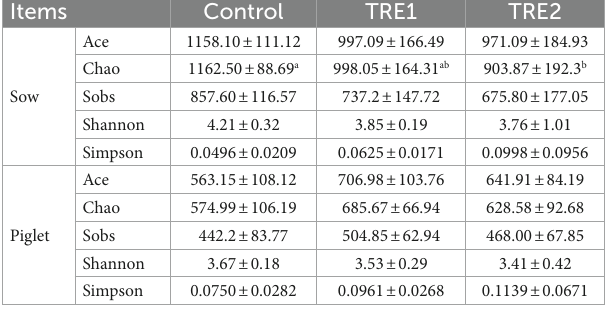
TABLE 5 Effects of feeding bamboo powder on alpha diversity of fecal microbiota for sows and piglets.